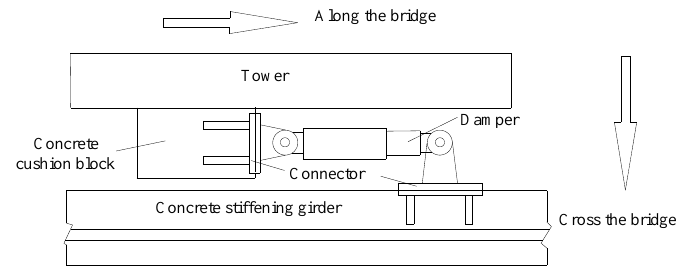
Figure 5. Installation of a longitudinal viscous damper.